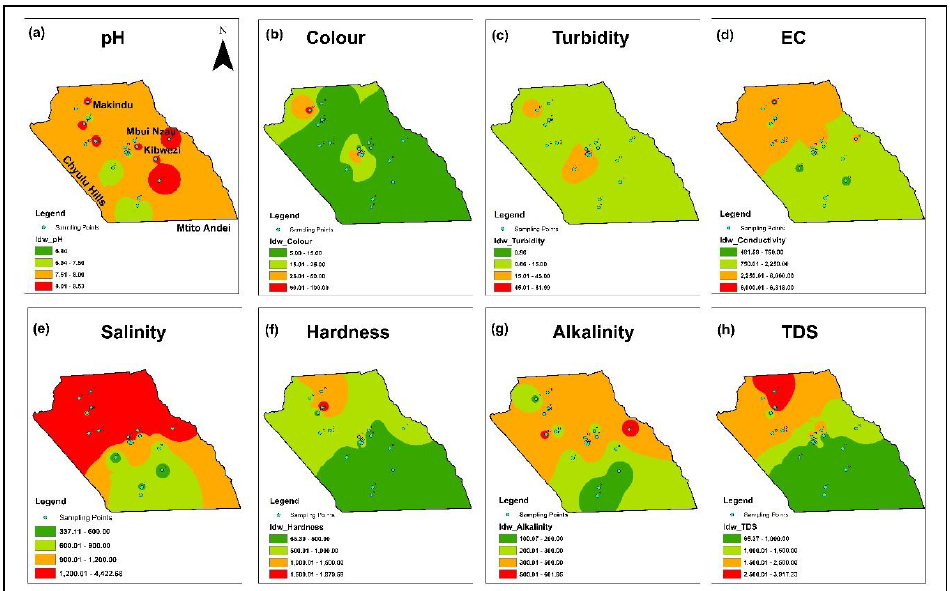
Figure 2. Spatial variation of pH ( a ), colour ( b ), turbidity ( c ), Electrical Conductivity EC ( d ), salinity ( e ), hardness ( f ), alkalinity ( g ), and Total Dissolved Solids (TDS) ( h ) in groundwater in Makueni County in November 2018 where, areas in red exceed the recommended limits for drinking water of these parameters. Geosciences 2020 , 10 , 62